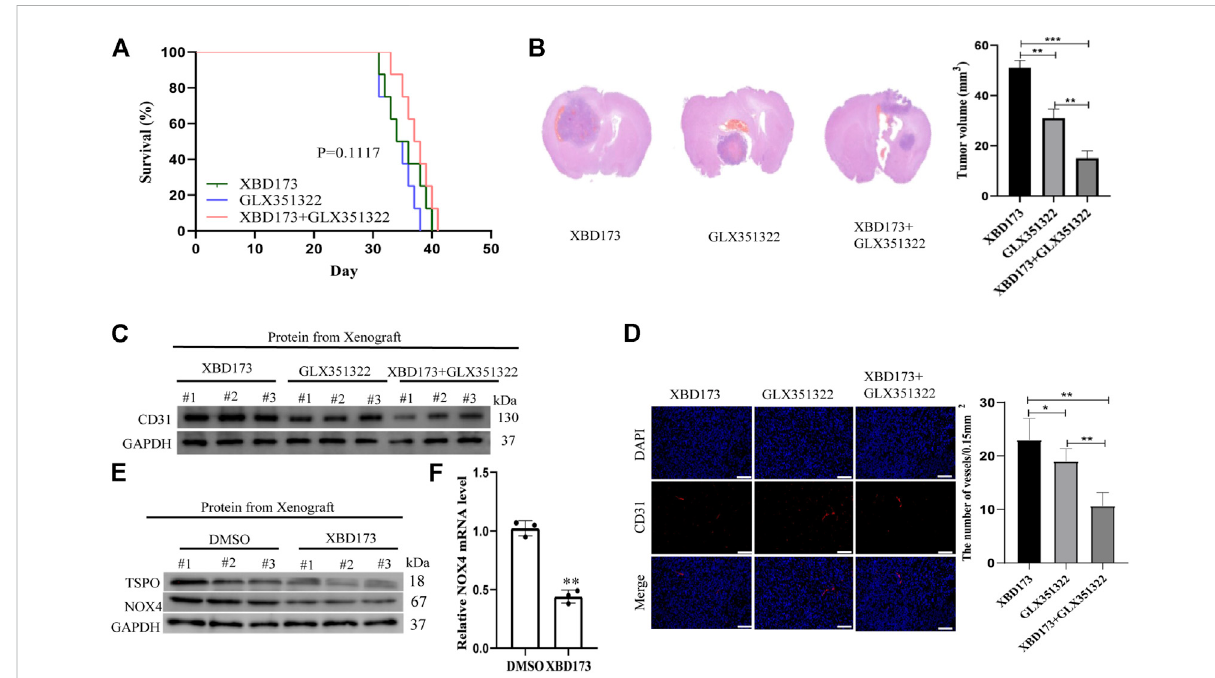
FIGURE 5 TSPO triggered ROS production via NOX4 in an intracranial xenograft glioma model. (A) Survival curves for the mouse intracranial xenograft glioma model following the control, 2 weeks injection of the XBD173 or GLX351322 treatment in normal saline; (B) H&E staining of the brains isolated from mice received the indicated treatments. Scare bar: 100 μ m; (C) Western blot analysis of the levels of the angiogenesis-associated protein (CD31) in the 2 weeks injectionoftheXBD173group,GLX351322treatmentinnormalsalinegroupandboththetreatmentsgroups; (D) Representativeimmunohistochemical analysis of CD31 expression in intracranial Xenograft tissue. Scale bars, 50 μ m. Three independent experiments were performed. The data are presented as themeans±SEM.Allimagesrepresentedasthemean±SDofthreeindependentexperiments;* p < 0.5;** p < 0.01;*** p < 0.001; (E) Westernblotveri fi edthe lossofTSPOandNOX4expressioninanintracranialxenograftgliomamodelinwhichthegenewasknockeddownusingthesyntheticligandXBD173; (F) The relative mRNA expression levels of NOX4 are compared between the DMSO and XBD173 group based on real-time PCR results; * p < 0.5; ** p < 0.01; *** p <